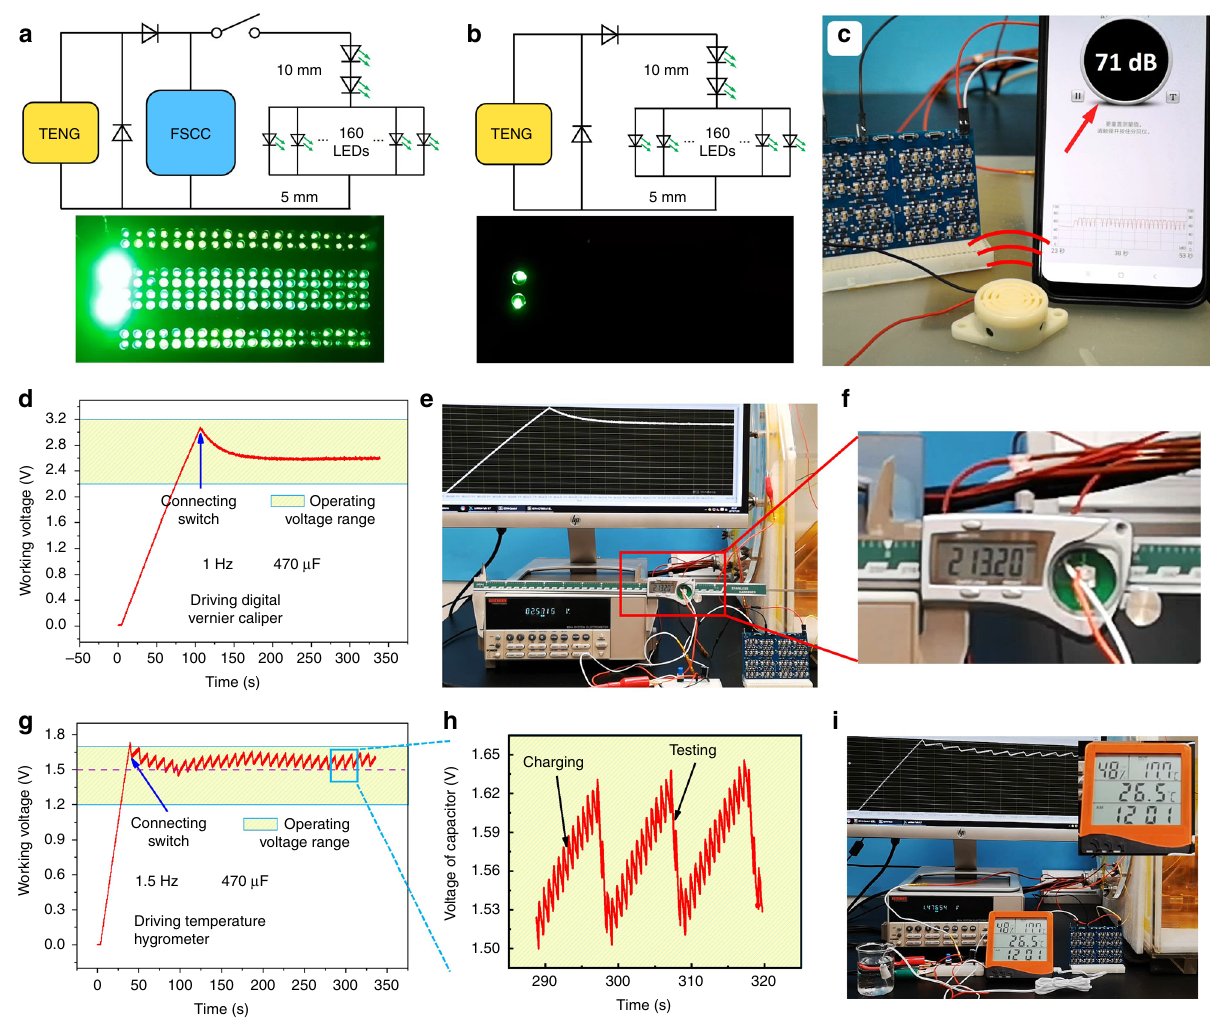
Fig. 5 Applications of FSCC power management for TENG. Lighting 160 green LEDs with 5 mm diameter in parallel and 2 green LEDs with 5 mm diameter in serial by FSCC power management system ( a ) and TENG ( b ) directly at 1 Hz, the circuit diagram used to light LEDs is above the optical image . c Driving a buzzer with the pulse output mode at 1 Hz. d Voltage-time curve for continuously driving a medium size digital vernier caliper and e the corresponding image. f the enlarged image of the selected area in e . g Voltage-time curve of a temperature hygrometer with three sensors driven by 96-unit FSCC power management system. h The detailed voltage curve of the selected area in g . i The actual image of driving the temperature hygrometer (24.6 μ A at 1.6 V) by a constant voltage source. In